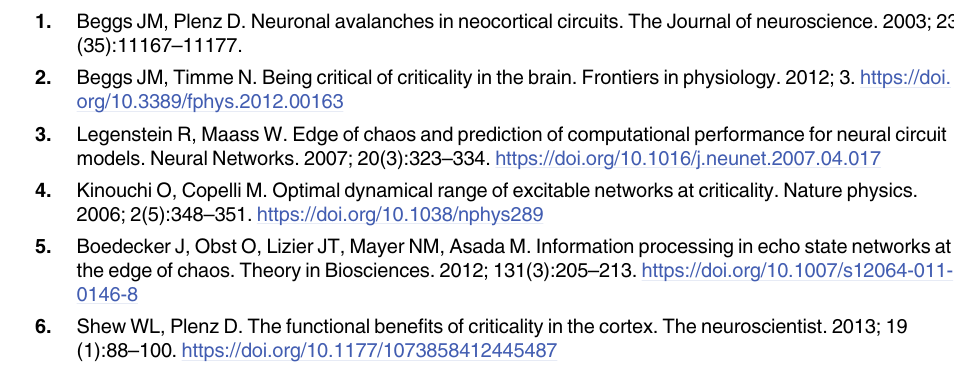
and the indicated distributions (a positive R means that data is more likely power-law distrib- uted, while a negative R means the compared distribution is more likely a better fit). For fur- ther details, check the powerlaw package detailed description [47]. S2 Table. Exponents α and τ for different activity thresholds θ ( N E = 200, N I = 40). Power- law exponents for duration and size for the activity thresholds θ described in Fig 3. R goodness of fit (loglikelihood ratio between a power-law and an exponential fit) in each case